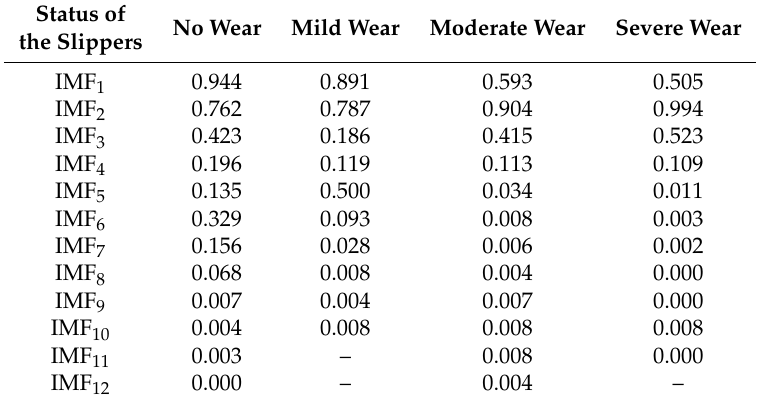
Table 1. The correlation coefficient values of the IMF components of the four states.